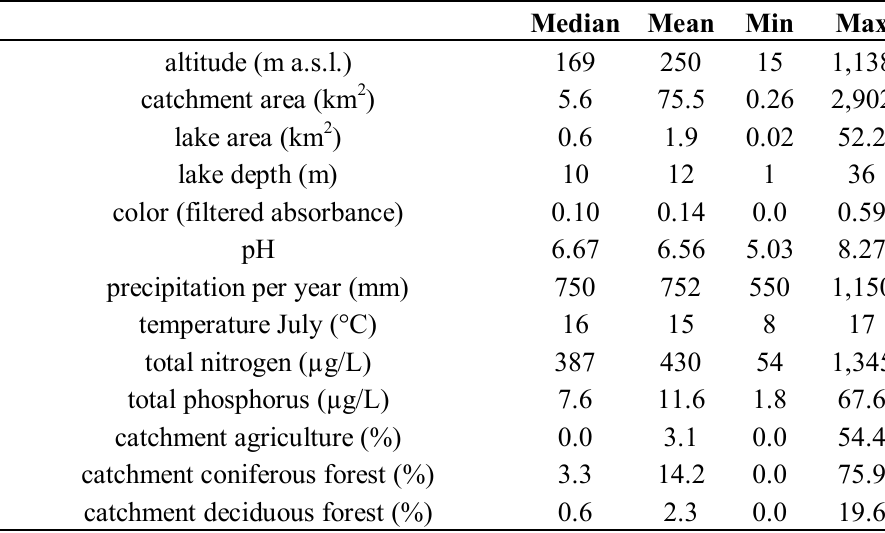
Table 1. Characteristics of the 105 study